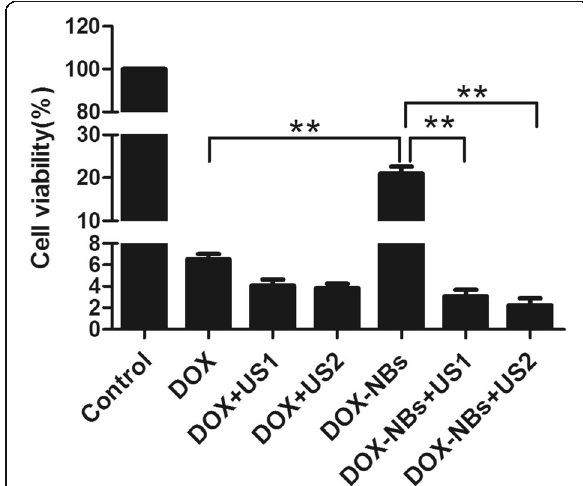
Fig. 8 The comparison of cell viability in different